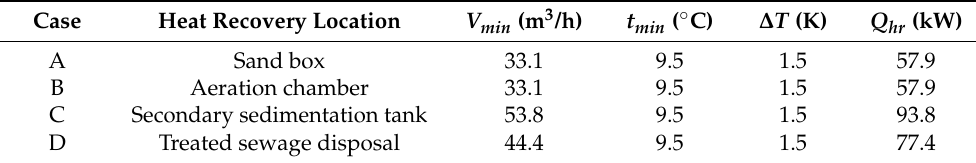
Table 3. Results of calculations of the heat recovery potential from wastewater at different locations at the treatment plant.